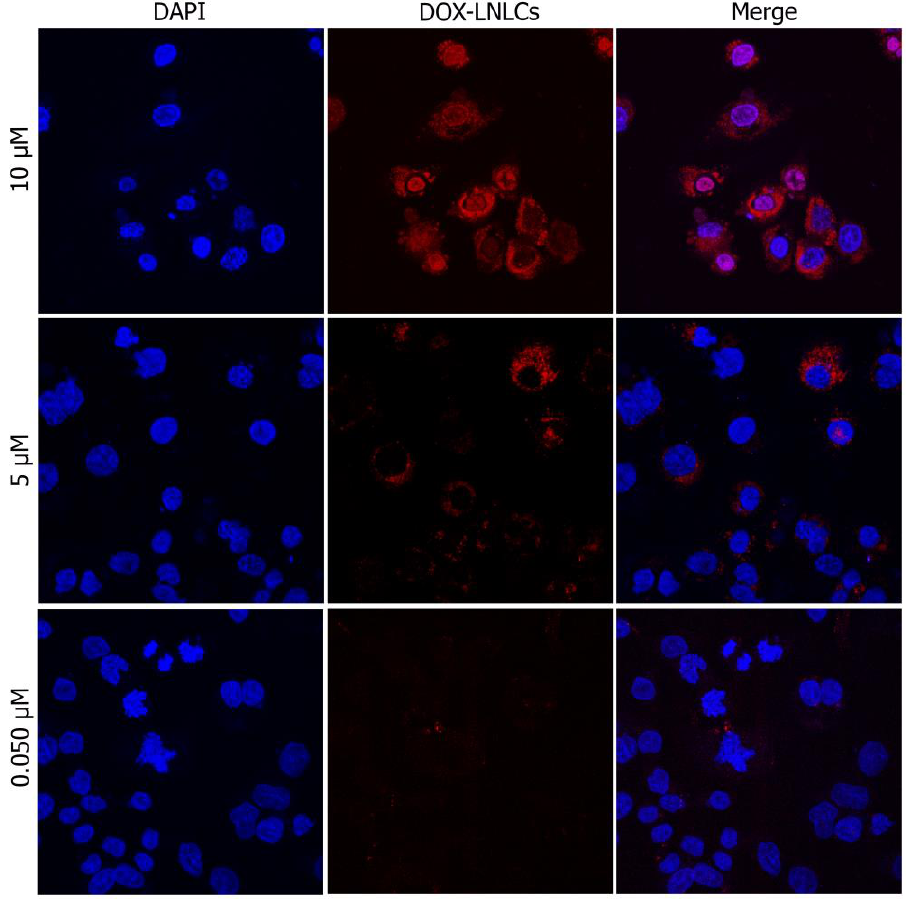
Figure 10. Representative confocal images of cellular internalization and subcellular distribution of DOX-LNLCs nanoassembly in HepG2 cells (63×), after 24 h incubation with DOX concentrations of 10, 5 and 0.05 μM. Cells’ nuclei are counterstained with DAPI (blue , left column); DOX-LNLCs appear in red (middle column), as a result of the emission of DOX. The right column depicts the merged images for each DOX concentration.